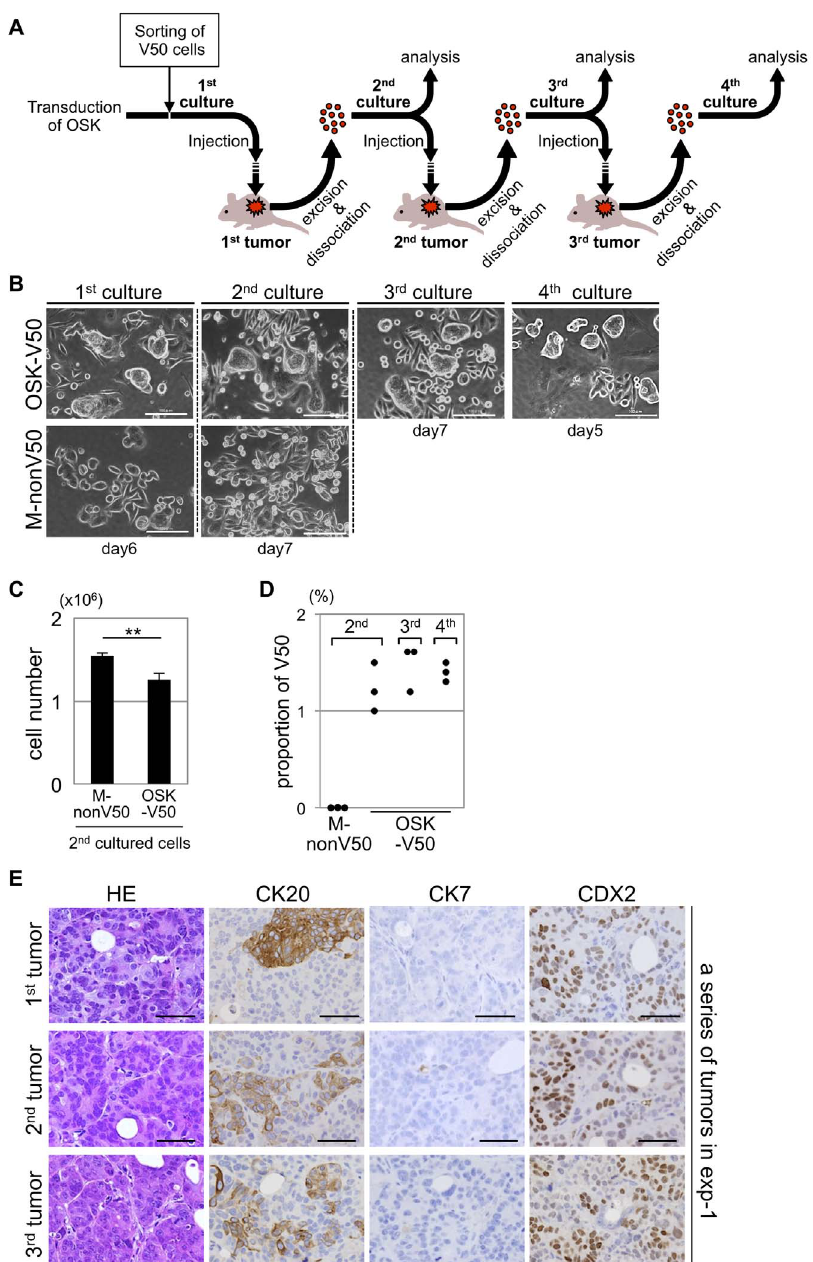
Figure 7. The self-renewal capacity of the OSK-V50 cells invivo . (A) A schematic representation of serial transplantation experiments. (B) The morphological features of a series of cultured cells in the serial transplantation experiments. The day shown under the panel indicates the culture period after sorting for the first cultured cells and after dissociation from tumors for the second, third and fourth cultured cells. In the case of OSK-V50 cells, the morphological features in each culture were the same over three passages in vivo , and the features were similar to those shown in Figures 4A and 5B. Scale bars: 100 m m. (C) The cell proliferation of the second cultured cells in vitro . A total of 2 6 10 5 cells cultured for four to six days after dissociation were seeded and counted 72 hr later. In the second cultured cells, the number of OSK-V50 cells was significantly lower than that of M-nonV50 cells (n=3). **P , 0.01, t-test. (D) The proportion of V50 cells in the second, third and fourth cultured cells. The panel shows the proportion of V50 cells in each culture from three independent experiments. The V50 cells were maintained over three passages in vivo , whereas V50 cells were not observed in the second M-nonV50 cultured cells. The representative dot plots obtained by FCM are shown in Figure S6. (E) The pathological findings of xenograft tumors derived from OSK-V50 cells. The panel shows the histological findings of a series of tumors obtained from serial transplantation experiments. The results of the other series of tumors are shown in Figure S7. The OSK-V50 cells serially showed the same pathological findings as those described in Figures 6A and 6B; there was cell diversity and glandular structures observed by HE staining, and CK20- and CDX2-positive, and CK7-negative findings for the immunostaining. exp: experiment. Scale bars: 50 m m.